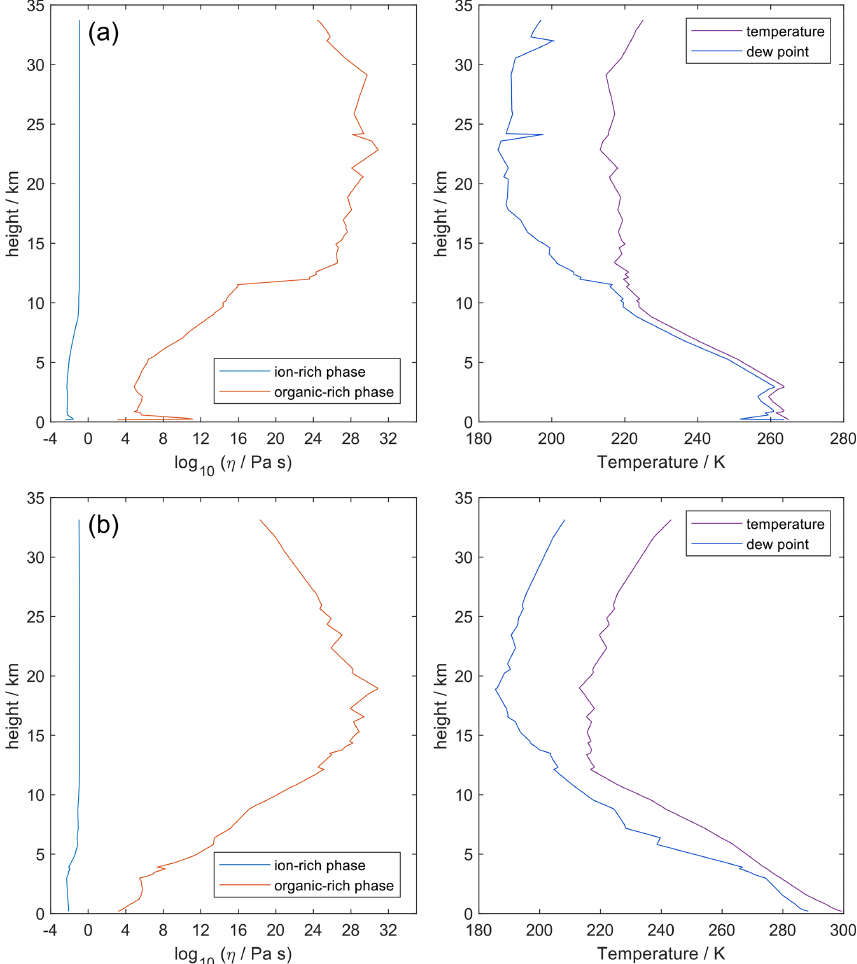
Figure 14. Viscosity predictions for observed temperature and relative humidity profiles using liquid–liquid phase separated aerosol particles containing α -pinene SOA surrogate compounds and ammonium sulfate. Relative humidity and temperature data are taken from atmospheric soundings collected at Maniwaki, Quebec (station code: WMW) for 7 February 2020 at 12:00UTC (a) and 1 July 2020 at 00:00UTC (b) . Left panels show AIOMFAC-VISC viscosity predictions, and right panels show corresponding measurements of the air and dew point temperatures. OIR is approximately equal to 1 for warm surface conditions and increases gradually to approximately 11 for the coldest observed temperatures owing to the increased condensation of semivolatile organic compounds in this surrogate system. Sounding data are provided by the University of Wyoming (http://weather.uwyo.edu/upperair/sounding.html, last access: 4 October